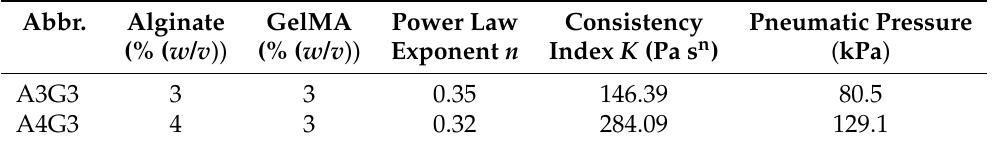
Table 1. Biomaterial ink compositions as employed in this study and abbreviations used throughout this work. Power law exponent and consistency index according to the Ostwald–de Waele relationship were determined as mentioned in Section 2.3 and used for the calculation of the specific pneumatic pressure for printing performance